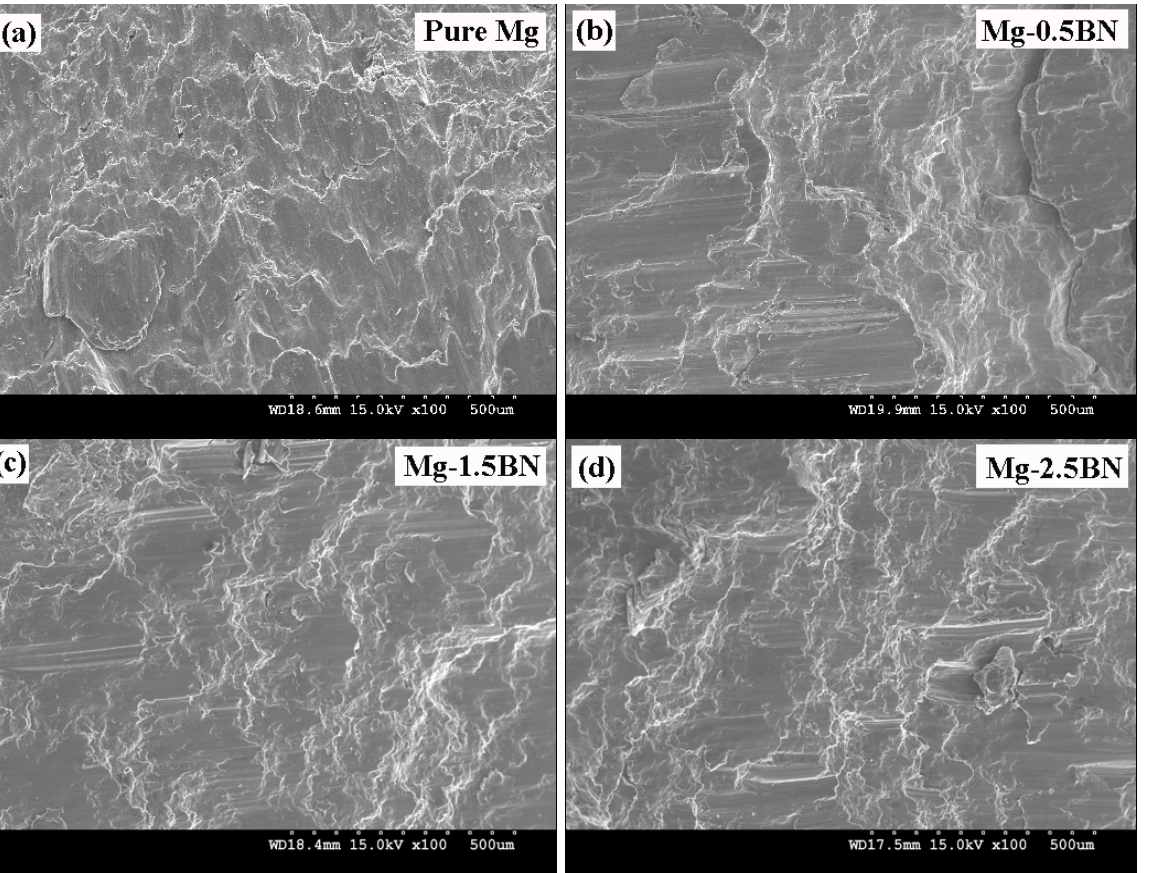
Figure 6. Representative compressive fracture surfaces showing shear bands in ( a ) pure Mg; ( b ) Mg-0.5BN; ( c ) Mg-1.5BN; and ( d ) Mg-2.5BN